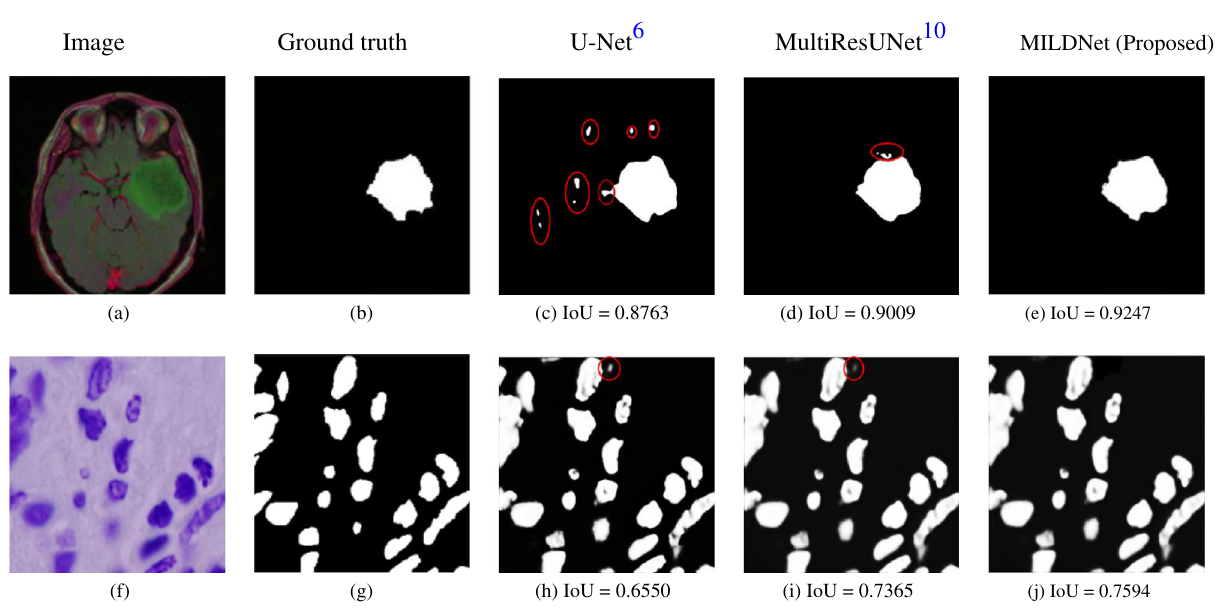
Figure 13. The non-tumor region in the MRI 15 image (a) contains small bright green areas (outliers), which resemble tumor region (ROI). The cell nuclei microscopy 17 image (f) has also some bright particles (outliers), which are visually very similar to the cell nuclei (ROI). MILDNet successfully discarded the outliers from the predicted masks (e,j) , with (b,g) being the ground truths. Red circles show the incorrectly segmented outliers by the classical U-Net (c,h) and the MultiResUNet (d,i)